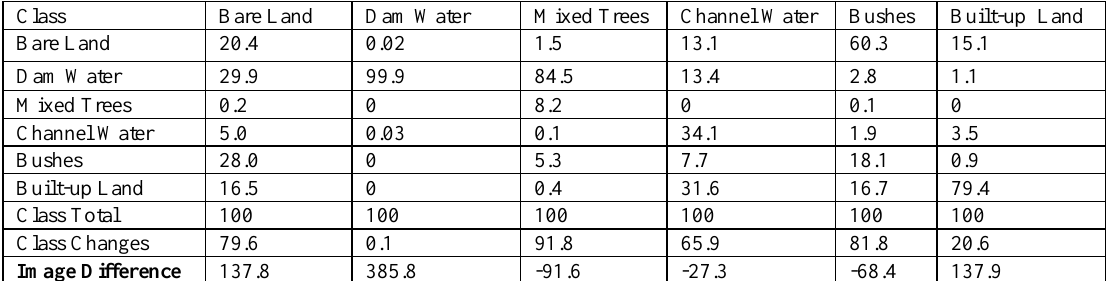
Table 6: Change Detection Percentage Operational Land Imager Data from Spring to Autumn Season Class Bare Land Dam Water